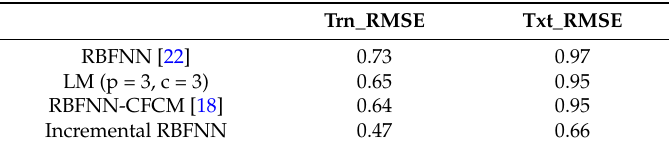
Table 3. Comparison of RMSE values for treadmill